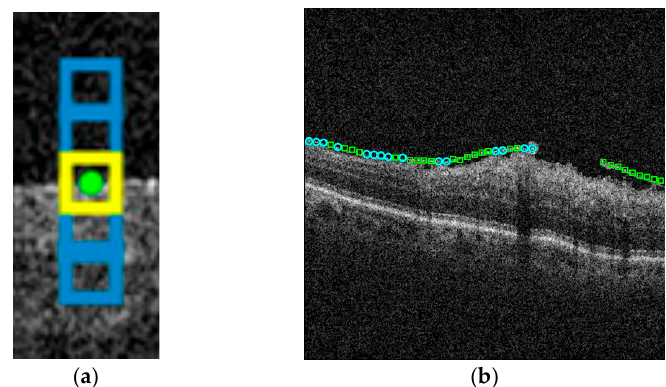
Figure 1. ( a ) Vertical window around a ROI point. Central region surrounds the analyzed point. ( b ) Result from the classification process. The circles show the area where the ERM is placed on the ILM, whereas the squares represent the ERM that is separated from the